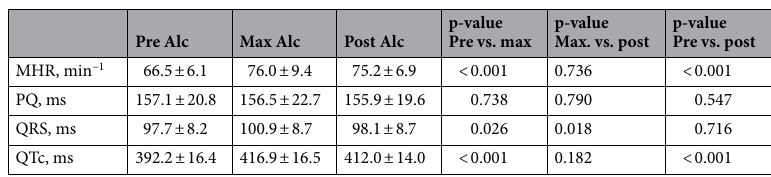
Table 2. Standard ECG parameters. N = 15. Differences were tested by the paired t-test. Pre Alc before alcohol intake, Max Alc maximum blood alcohol concentration, Post Alc after alcohol intake, MHR mean heart rate.